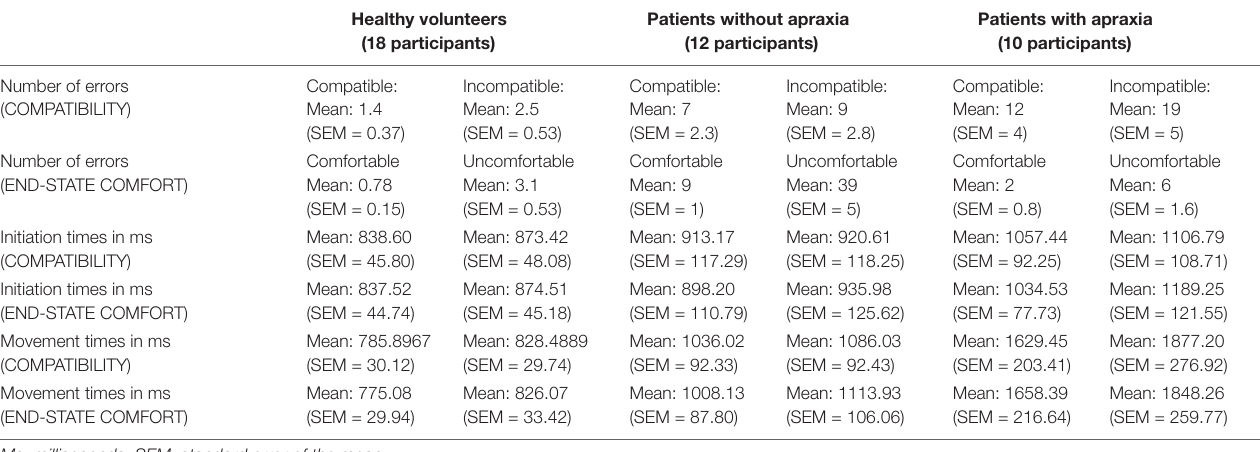
TABLE 3 | Results for error rates, and initiation and movement times, in compatible and incompatible trials, and in trials that ended comfortably versus the ones that did not.